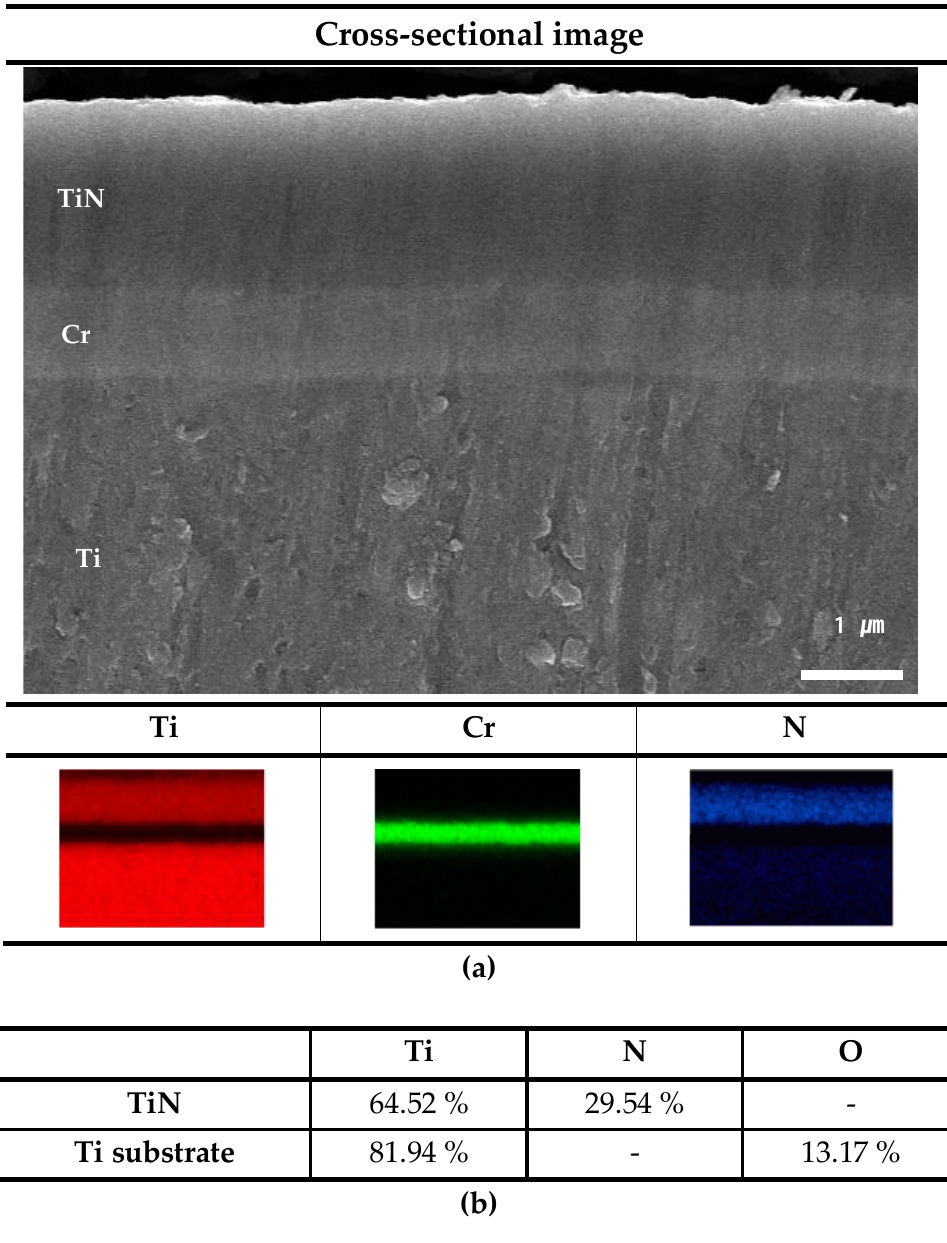
Figure 2. Cross-sectional images of TiN-coated specimen and EDS results (wt%). ( a ) Cross-sectional image of TiN-coated specimen; ( b ) EDS analysis of TiN coating.